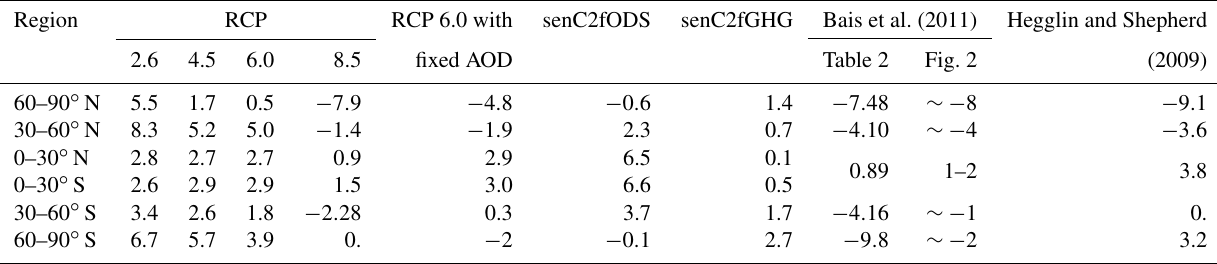
Table 5. Percent changes in UVI between 2100 and 1960. Results for RCPs 2.6, 4.5, 6.0 and 8.5 are obtained from EXP1. Results for RCP 6.0 with fixed AOD, senC2fODS and senC2fGHG are obtained from EXP2. Bais et al. (2011) first column results are obtained from Table 2 of the corresponding study; these are percent changes between 2090–2099 and 1975–1984. Bais et al. (2011) second column results are obtained by a rough estimate of percent changes between 2100 and 1960 from Fig. 2 of the corresponding study.